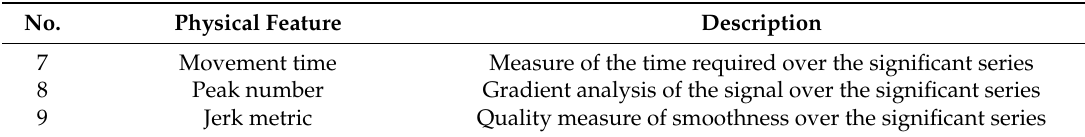
Table 3. Physical features calculation and